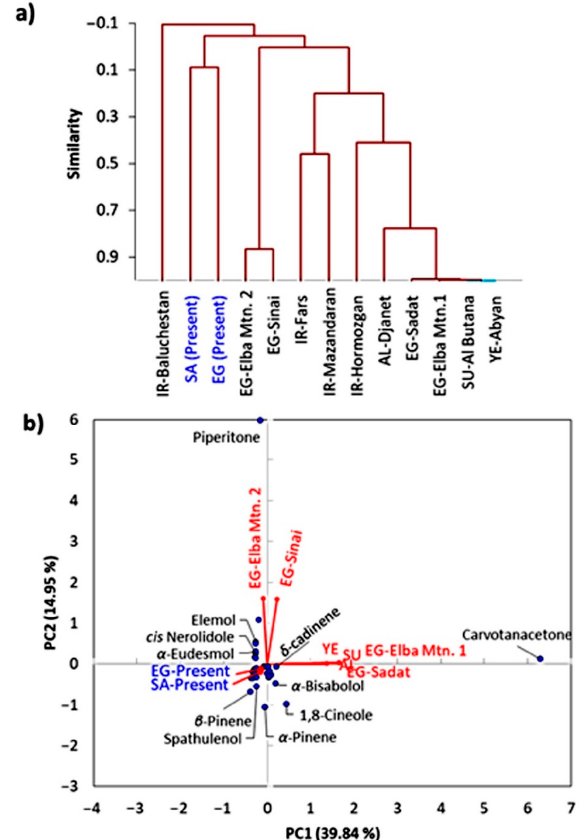
Figure 2. Chemometric analysis of the essential oil of different Pulicaria undulata ecospecies: ( a ) ag- glomerative hierarchical clustering (AHC) and ( b ) principal components analysis (PCA). SA: Suadi, EG: Egyptian, IR: Iranian, AL: Algerian, SU: Sudanian, and YE: Yemeni. The blue color represents the present samples.